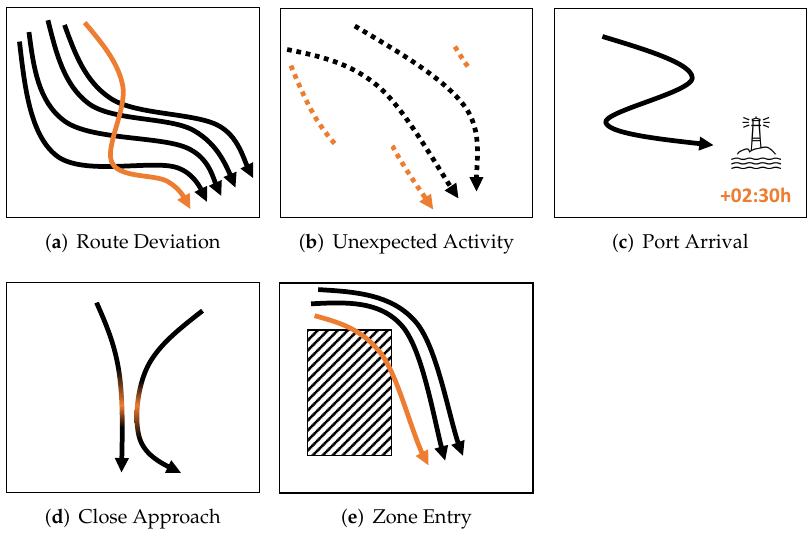
Figure 2. These general five AIS anomaly types, derived by Lane et al. [33], are used in the survey to classify the capabilities of published anomaly detectors. The arrows and data marked in orange in each figure indicate a potential deviation from the normally expected